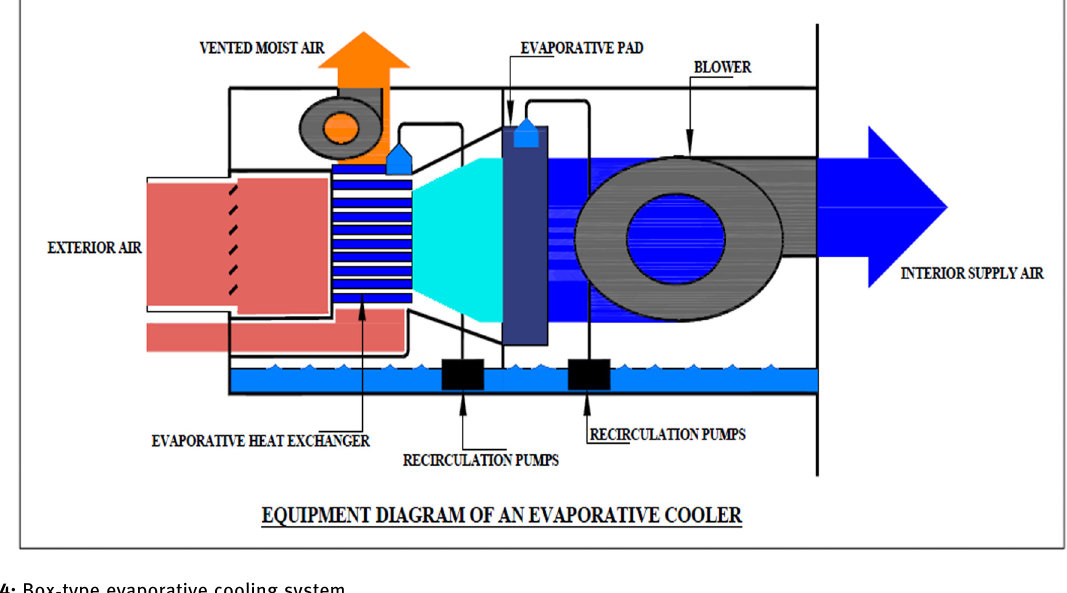
Figure 4: Box - type evaporative cooling system.